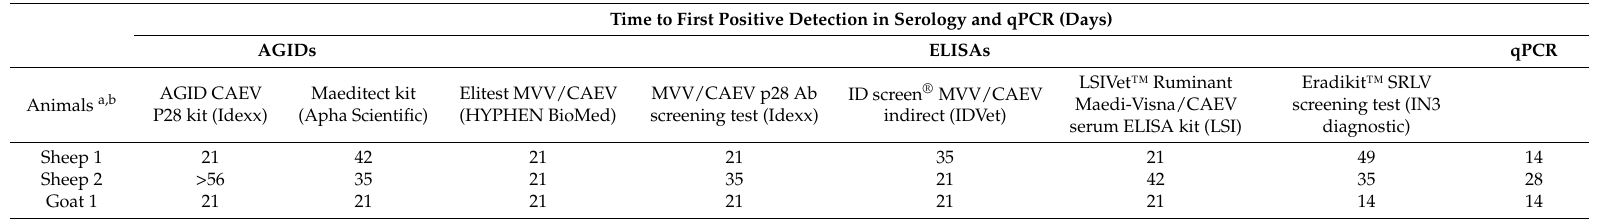
Table 4. Time to first positive detection by serology and real-time PCR (qPCR) after experimental